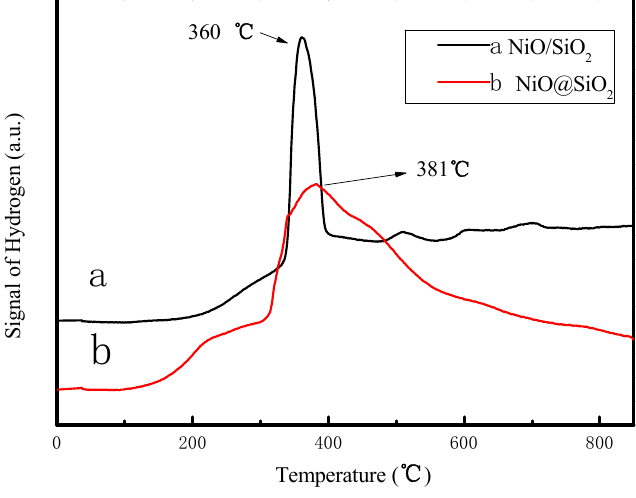
Figure 4. H 2 Temperature Programmed Reduction (H 2 ‐ TPR) profiles of ( a ) NiO@SiO 2 and ( b ) NiO/SiO 2 .